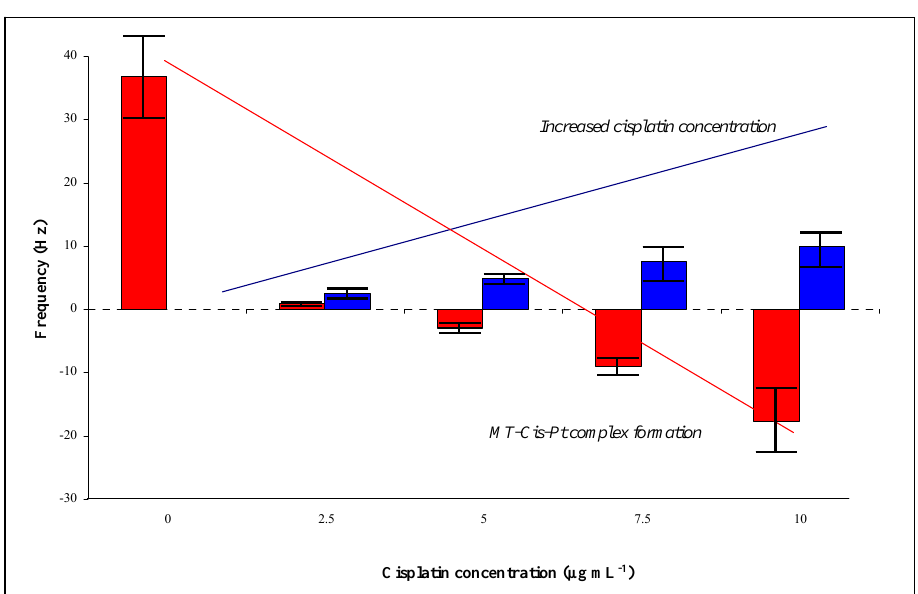
Figure 7. QCM analysis of MT-cisplatin interactions, n =